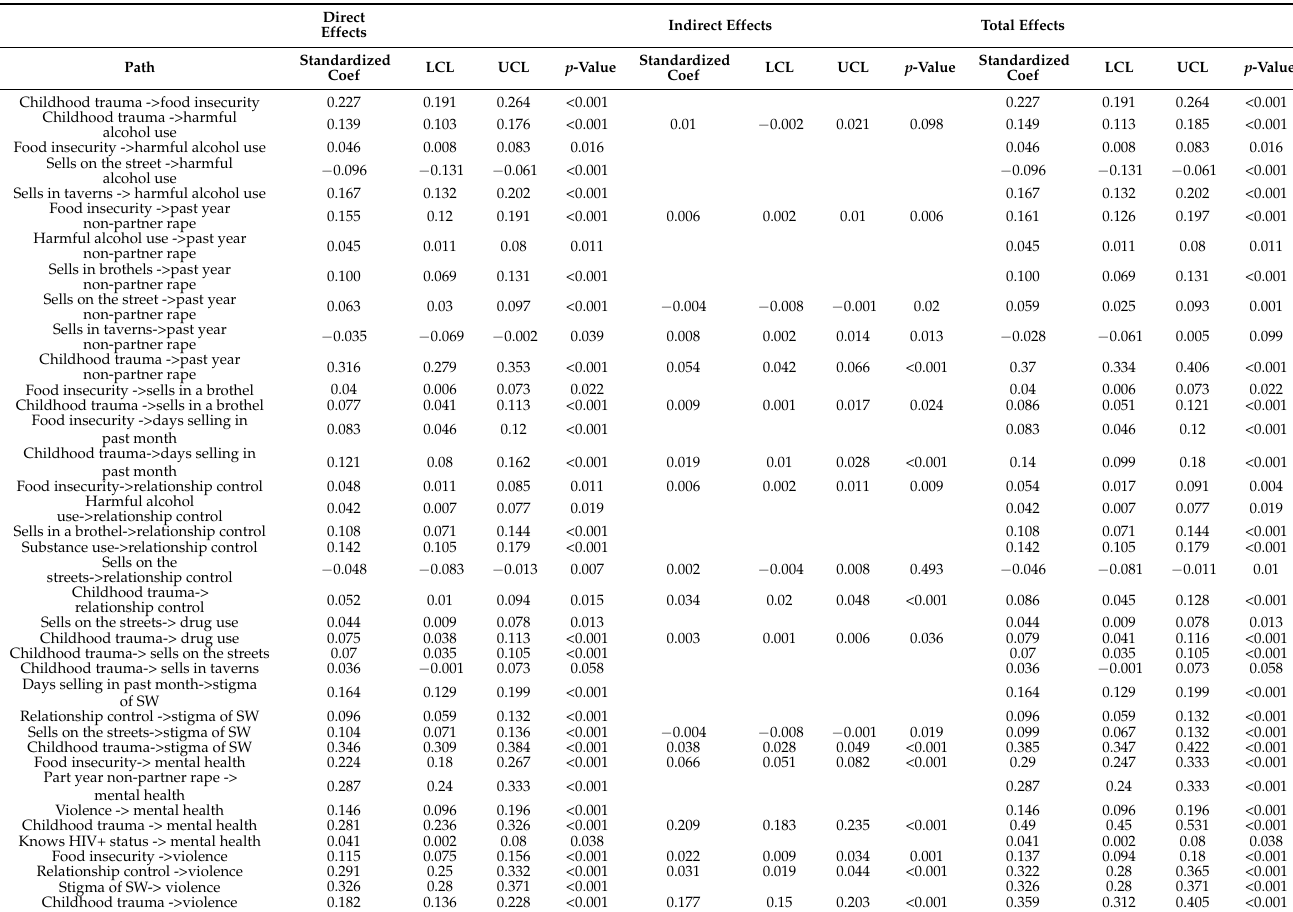
Table 3. Female Sex Worker Mental Ill Health Vulnerability Model: Direct Effects, Indirect Effects and Total